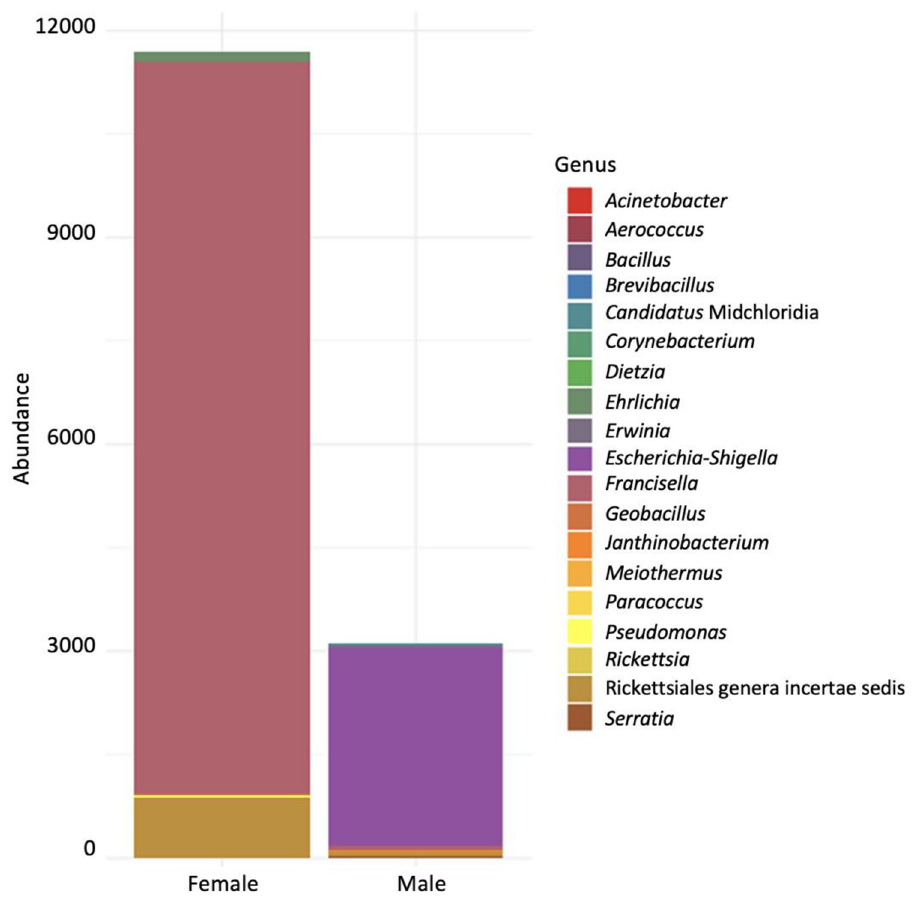
Fig 4. Genus’s level taxonomic composition of male and female Hyalomma scupense